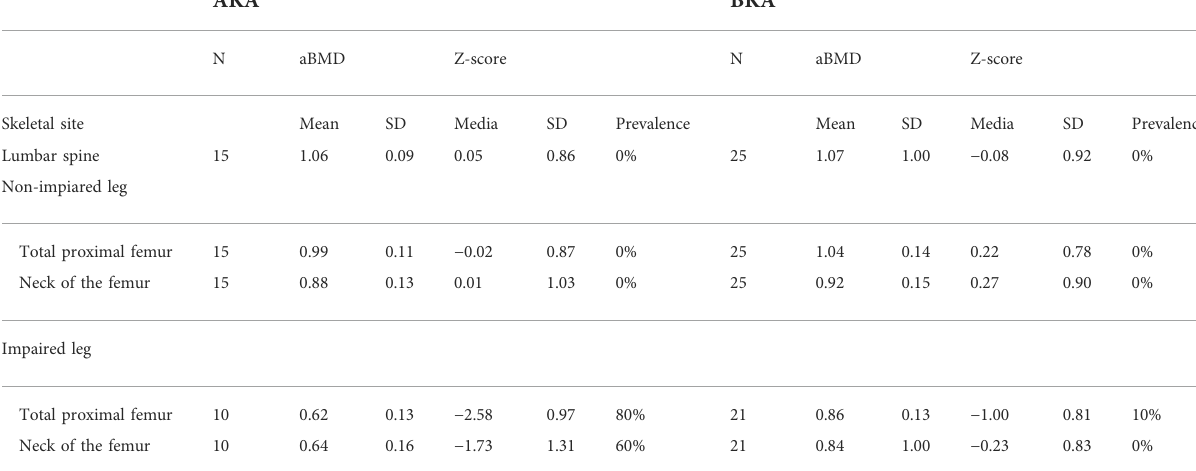
TABLE 2 Skeletal aBMD variables and prevalence of athletes with a Z-score ’ s value below the expected range for age according to the level of amputation. AKA BKA N aBMD Z-score